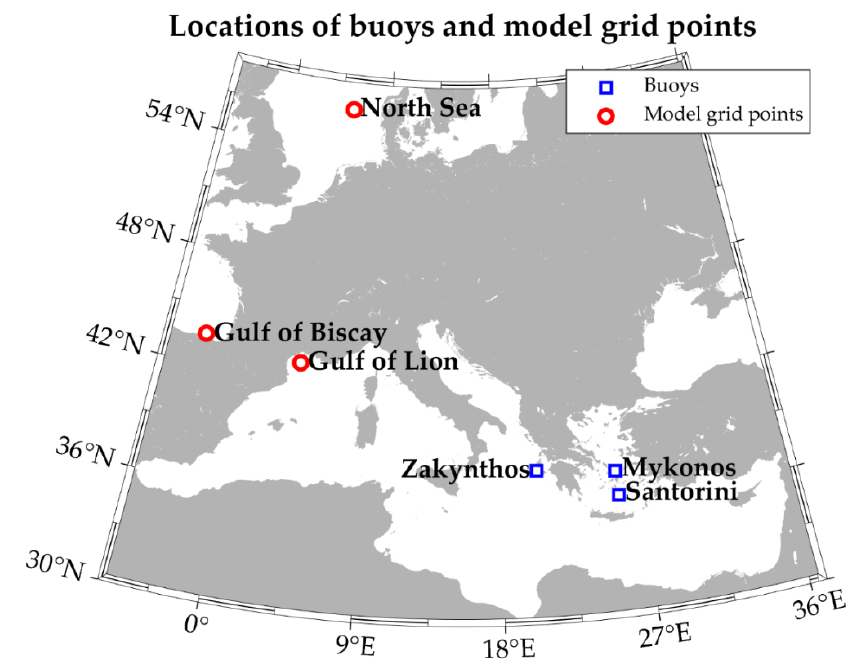
Figure 1. Locations of buoys and model grid points used in the analysis. Table 1. Location names, geographical coordinates, observation periods, sample size, and depth of wave data sets.